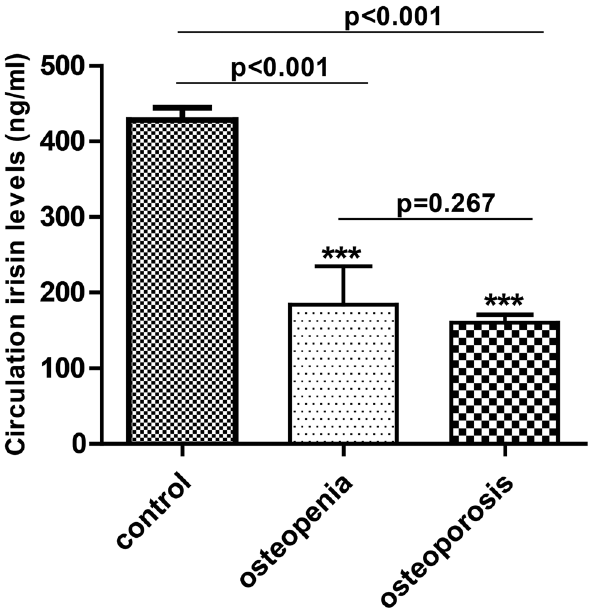
Figure 2: The serum irisin levels in the control, osteopenia, and osteoporosis